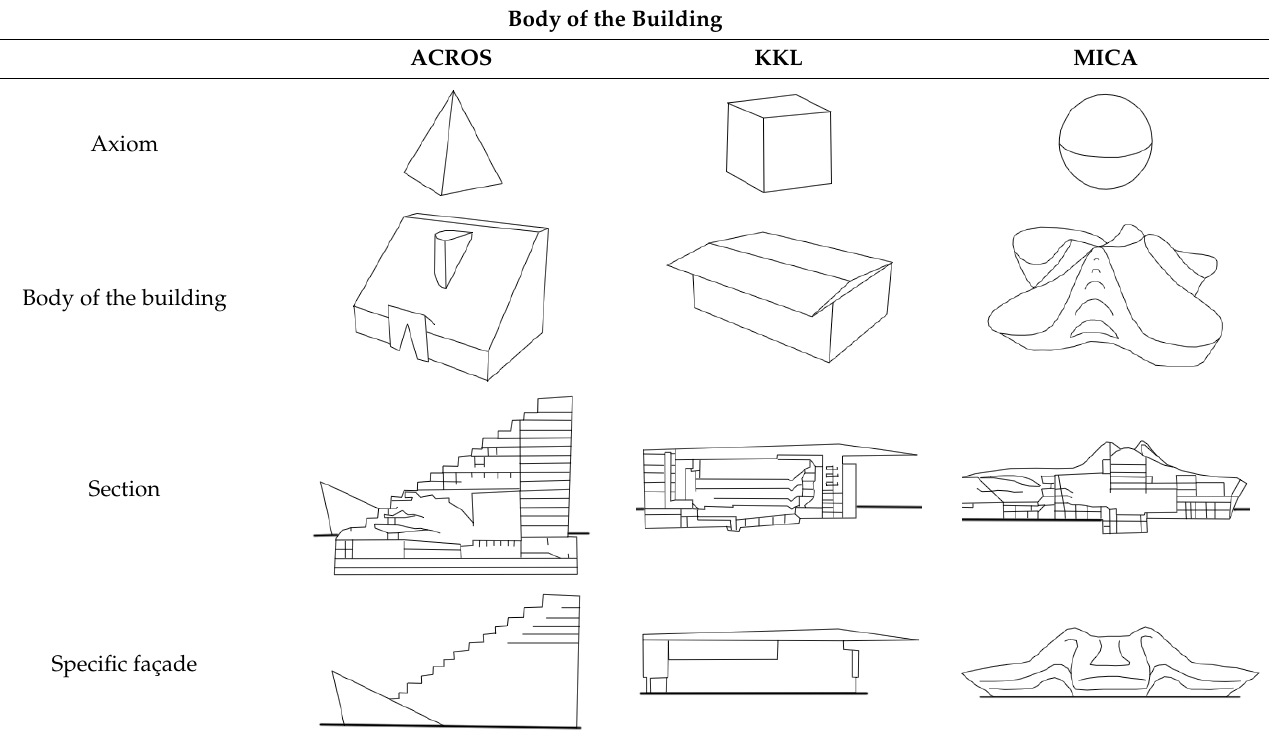
Table 3. Graphic comparison of the buildings’ bodies subjected to research: Prefectural International Hall “Asian Cross Road Over the Sea”, Kultur- und Kongresszentrum Luzern and Changsha Meixihu International Contemporary Art Museum, presenting the primary assumptions connected with intelligence-based design.